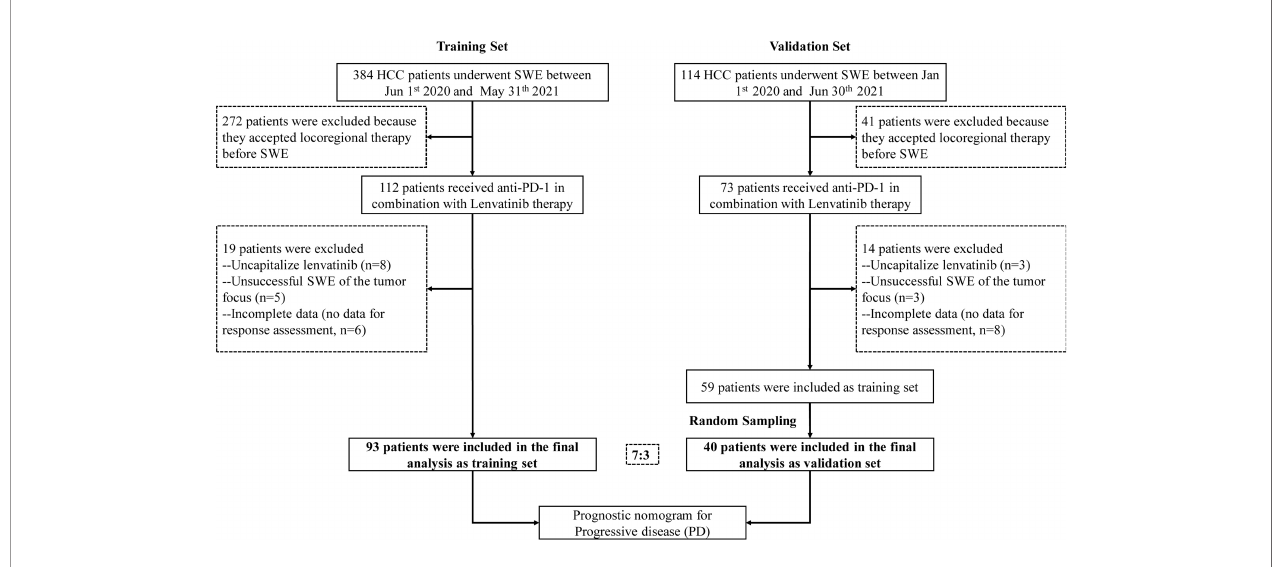
FIGURE 1 | Patient recruitment fl